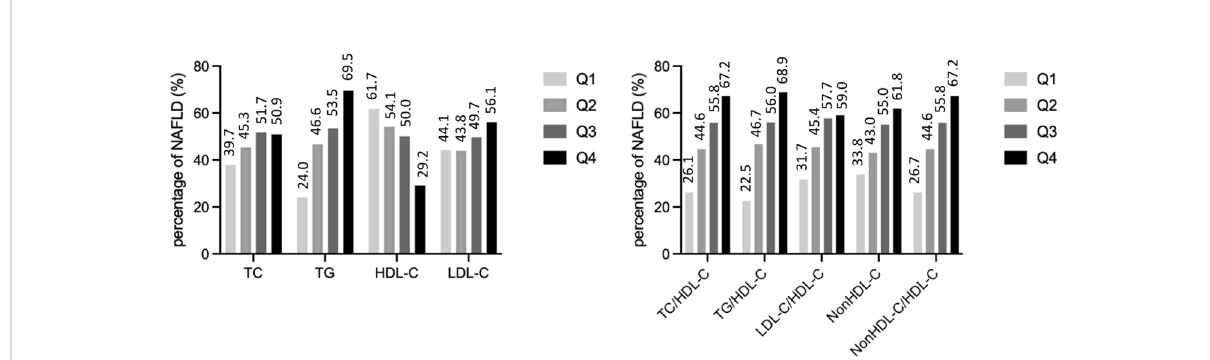
FIGURE 2 The prevalence of non-alcoholic fatty liver disease by quartiles of lipid parameters. TC, total cholesterol; TG, triglycerides; HDL-C, high density lipoprotein cholesterol; LDL-C, low density lipoprotein cholesterol.